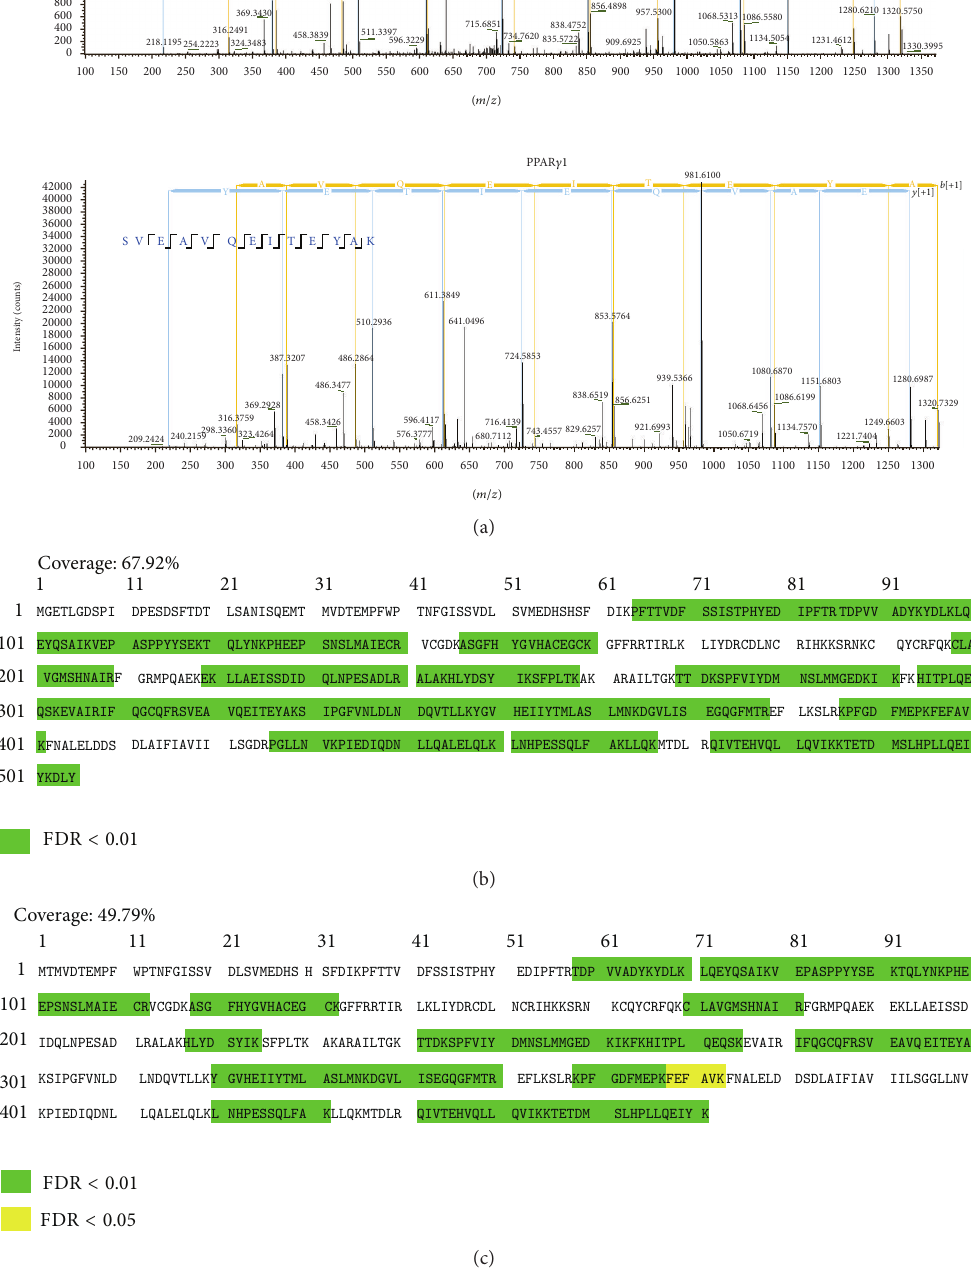
Figure 2: Identification of PPAR 𝛾 proteins using the SEQUEST algorithm. (a) Representative MS/MS spectra of PPAR 𝛾 2 proteins of the peptide [317-SVEAVQEITEYAK-329] and PPAR 𝛾 1 proteins of the peptide [289-SVEAVQEITEYAK-301] assigned by SEQUEST are shown. (b) Amino acid sequence coverage of identified exogenous PPAR 𝛾 2 proteins. The identified amino acid sequence is indicated. (c) Amino acid sequence coverage of identified endogenous PPAR 𝛾 1 proteins. The identified amino acid sequence is